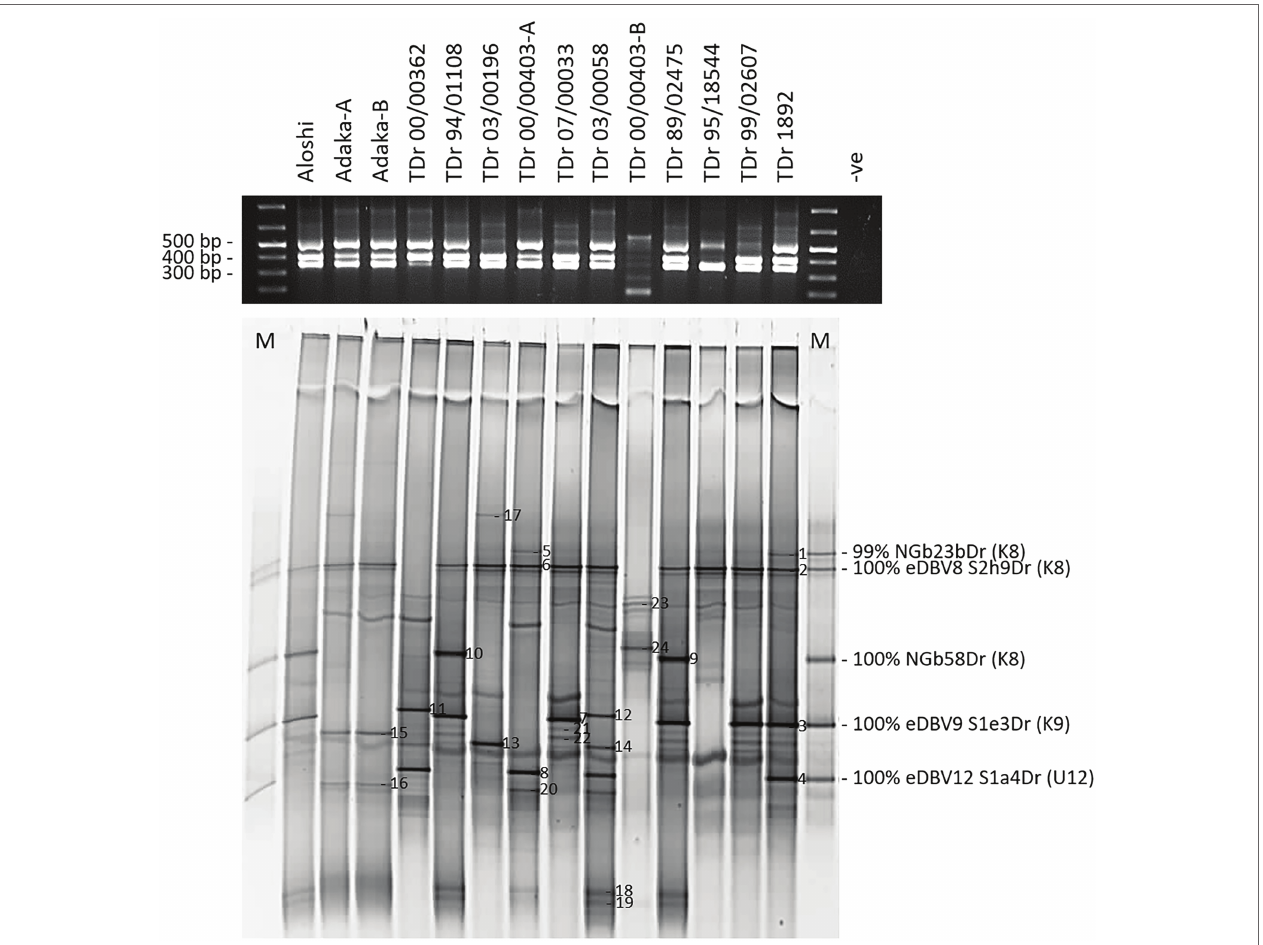
FIGURE 5 | Multiplex PCR-DGGE analysis of partial RT-RNaseH badnavirus sequences from two landraces (Aloshi and Adaka-A and -B) and ten breeding lines (TDr) of D. rotundata . Multiplex PCR amplifications using primers BF-GC, K8-R, K9-R and U12-R were checked for their expected amplicon sizes of 387 bp (K8), 447 bp (K9) and 565 bp (U12) on a 1.5% (w/v) agarose gel (black gel photograph on top) before DGGE analysis (bottom gel). The denaturing gradient was 35–50% and DGGE was performed at 80 V at a temperature of 60 ° C for 18 h. M denotes DGGE sequence marker and closest NCBI BLAST identity search results are indicated including monophyletic species group assignments K8 and K9 described by Kenyon et al. (2008) and U12 by Umber et al. (2014). Band numbers 1–24 were excised, reamplified and cloned. The corresponding DGGE sequences N1-24 are presented in Table 1 . D. rotundata accession TDr 00/00403-A and -B and landrace Adaka-A and -B are clones of the same yam accessions, but that have been grown separately for several